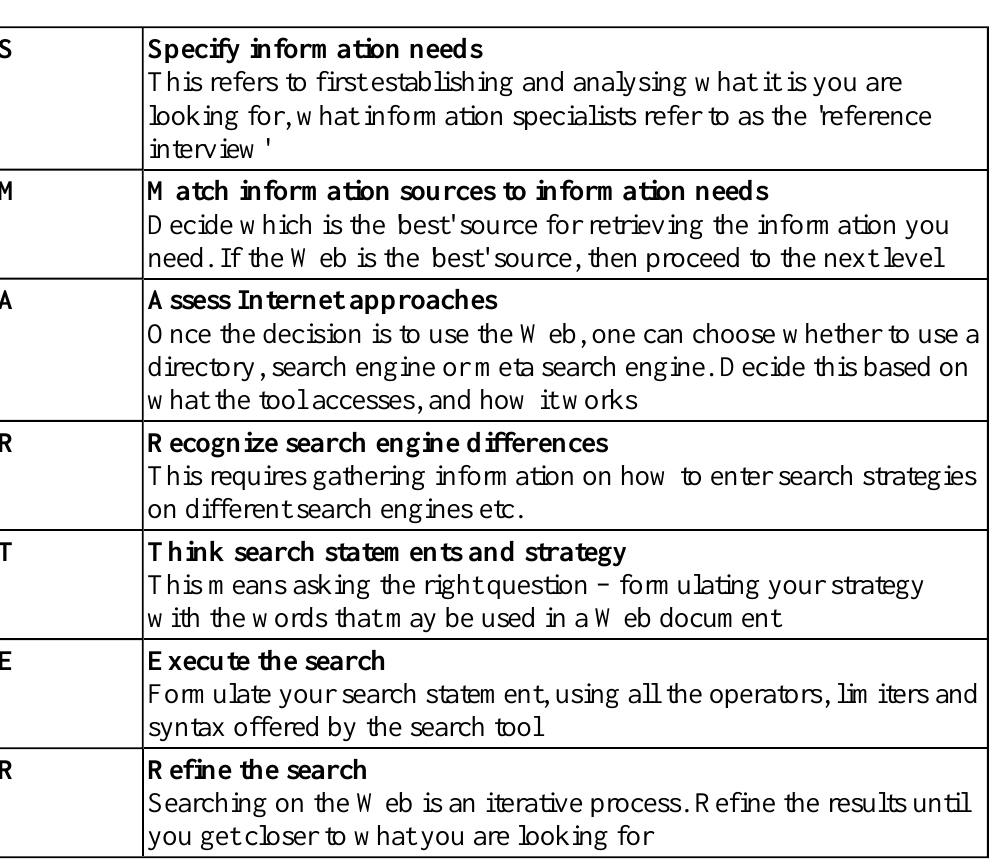
Table 2 'Searching Smarter' search